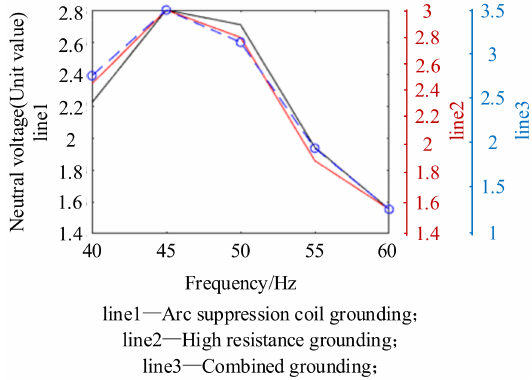
Figure 9. Relation curve between neutral voltage drift and frequency.